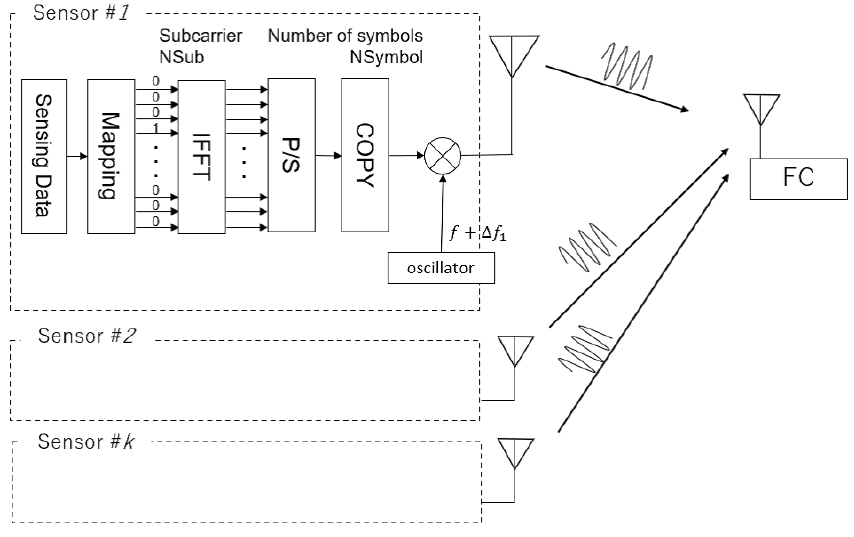
Figure 4. Transmitter side